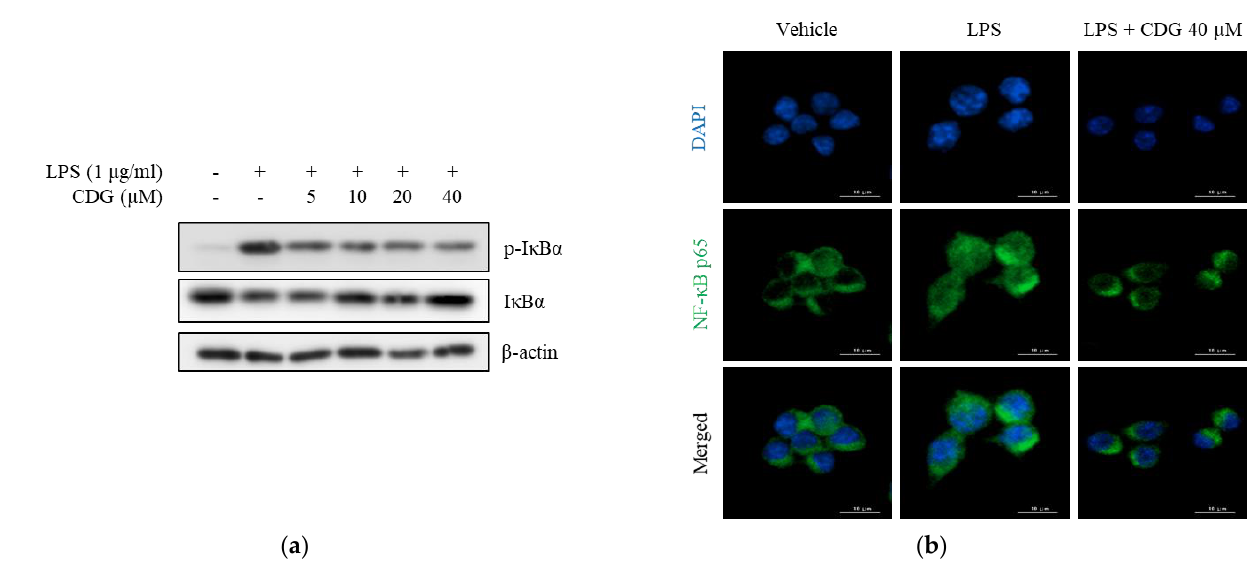
Figure 5. Effect of CDG on the NF- κB pathway. ImKC cells were treated with CDG (5, 10, 20, and 40 μM) for 2 h and stimulated by LPS (1 μg /mL) for the experiment. ( a ) Cell lysates were used for the analysis of the phosphorylation and degradation of IκBα by Western blot ting. β -actin was used as the loading control. ( b ) Immunofluorescence staining for NF- κB p65 (green) and compared with DAPI (blue). Scale bars: 10 μm. CDG, catechin- 7,4′ - O -digallate; NF- κB, nuclear factor kappa-light-chain- enhancer of activated B cells; LPS, lipopolysaccharide; DAPI, 4′,6 -diamidino-2-phenylindole. Scale bar = 10 µ